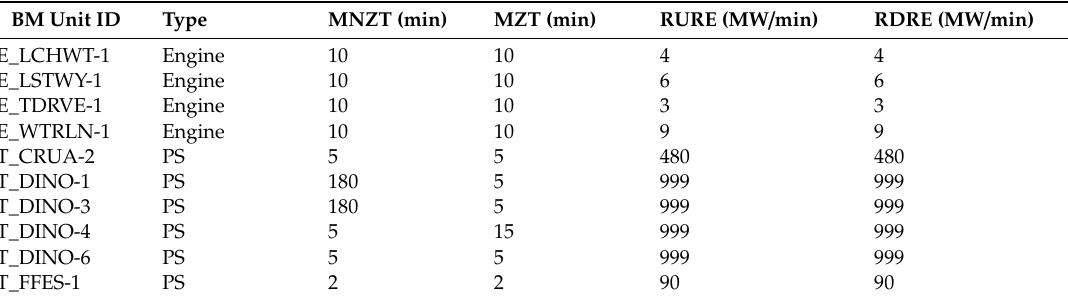
Table 3. Key dynamic parameters for units